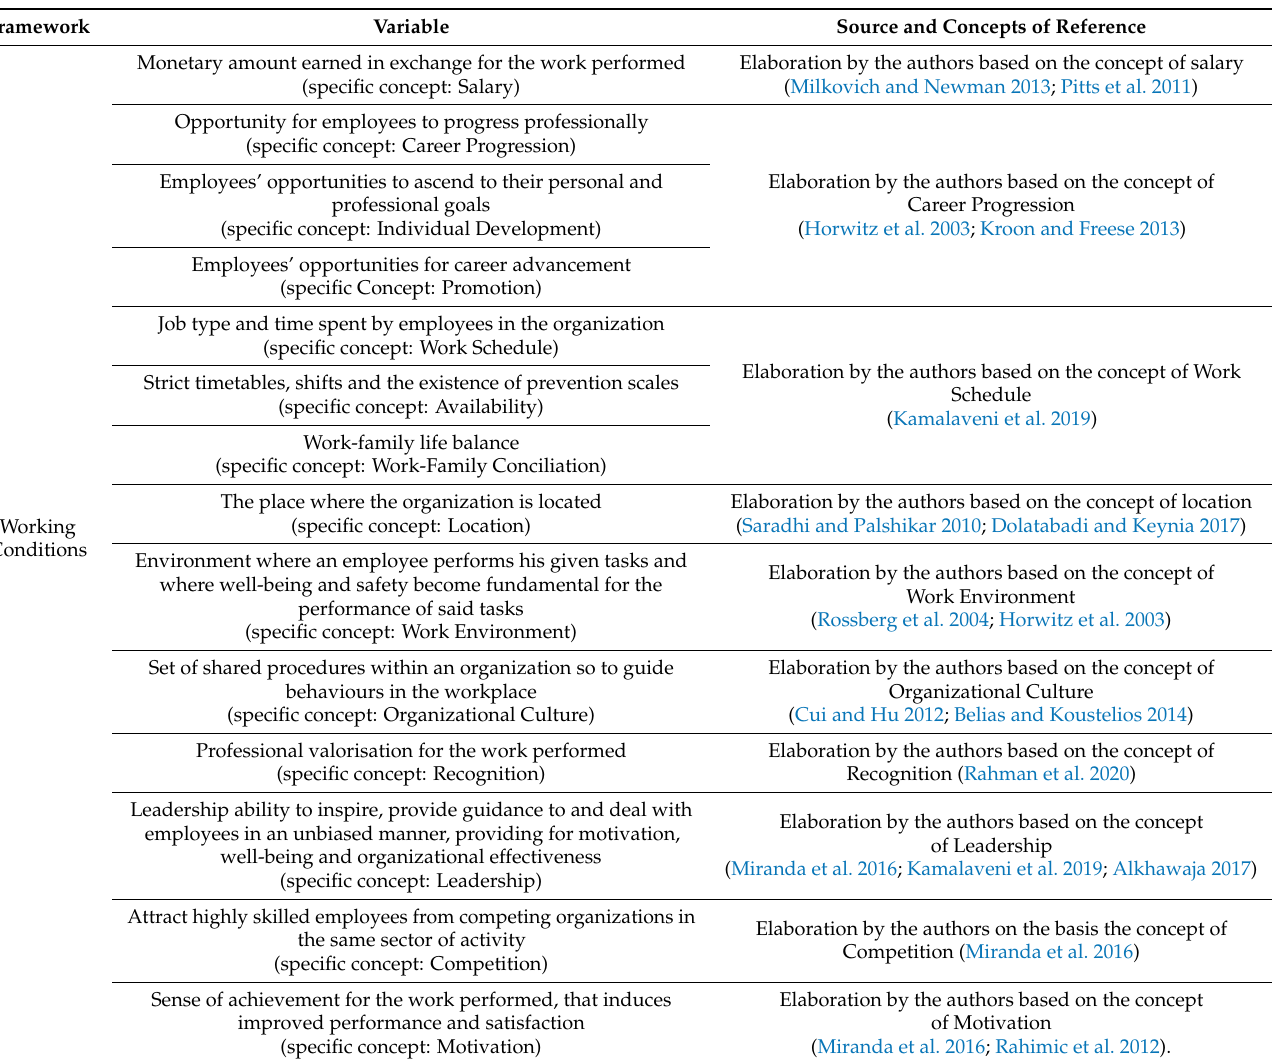
Table 1. Variables designed to measure the perceptions of the causes of churning of Human Resources. Framework Variable Source and Concepts of Reference